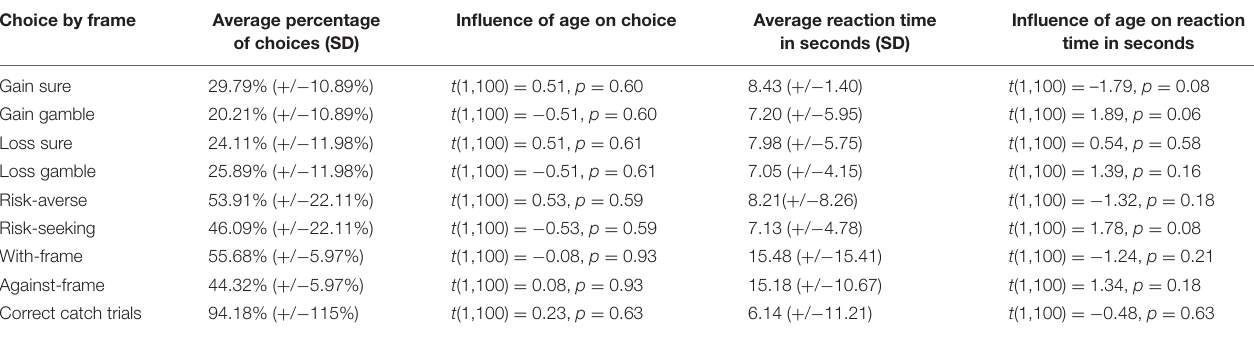
TABLE 3 | Behavioral performance on framing